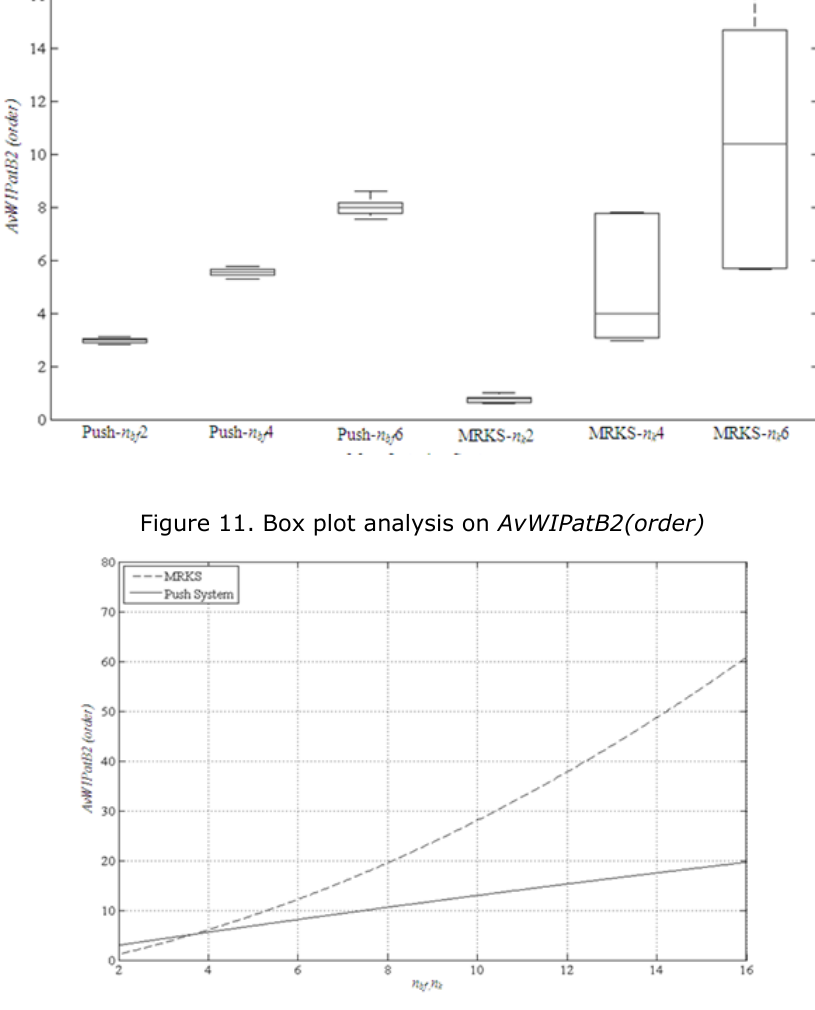
Figure 12. Effect of n bf, n k on